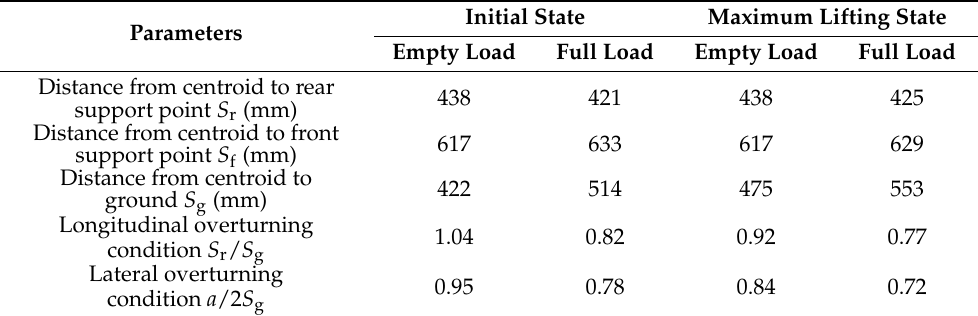
Table 2. Stability calculation parameters.